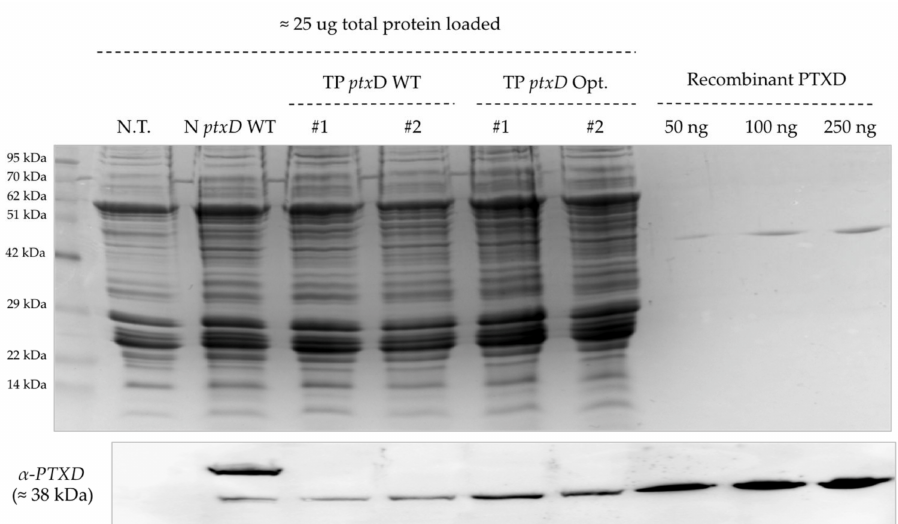
Figure 5. Biochemical characterization of produced transgenic lines displaying phosphite-metabolizing activity. A western blot analysis using the anti-PTXD antibody showed comparable amounts of recombinant enzyme expressed in the transplastomic lines carrying the two PTXD versions. The nuclear transformant N ptxD WT, the untransformed T222 wild type and variable amounts of the recombinant protein expressed in E. coli were included as controls. The upper panel displays a Coomassie-stained SDS-PAGE gel confirming equal amounts of total proteins for all lines (25 µ g). Densitometric analysis yielded a relative intensity of the 29 kDa band of 1:1.8:1.7:1.1:2.1:1.9 for, respectively, lanes N.T, N ptxD WT, #1,#2,#1,#2 (from left to